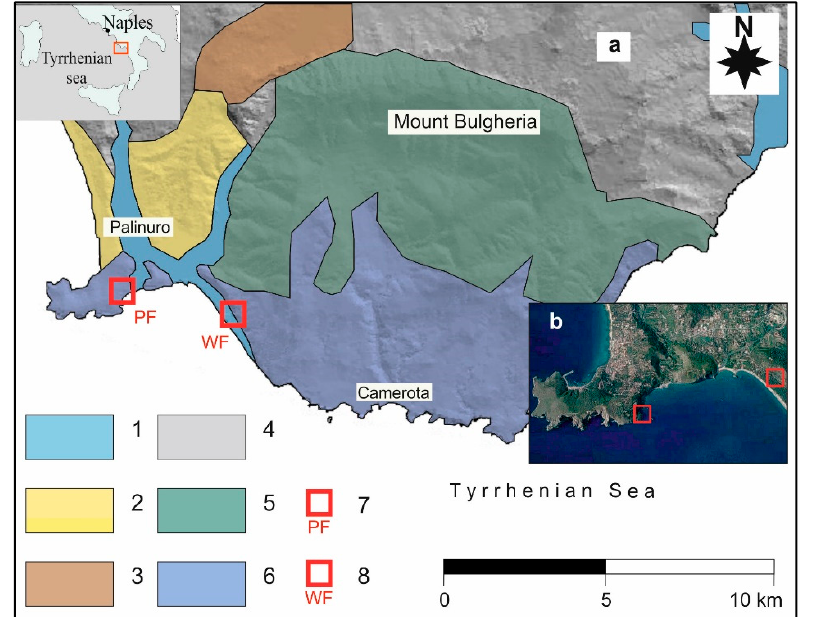
Figure 2. Schematic lithological map of the Cilento region ( a ). Key: (1) Alluvial deposits (Quaternary); (2) Conglomerates (Pliocene); (3) Arenaceous-pelitic flysch (Miocene); (4) Marly-clayey flysch (Tertiary); (5) Limestones (Mesozoic); (6) Dolomitic limestones (Trias); (7) slope potentially affected by plane failures of rock blocks; (8) slope potentially affected by wedge failures of rock blocks (modified by [25]). Satellite image by Google Earth ( b ).